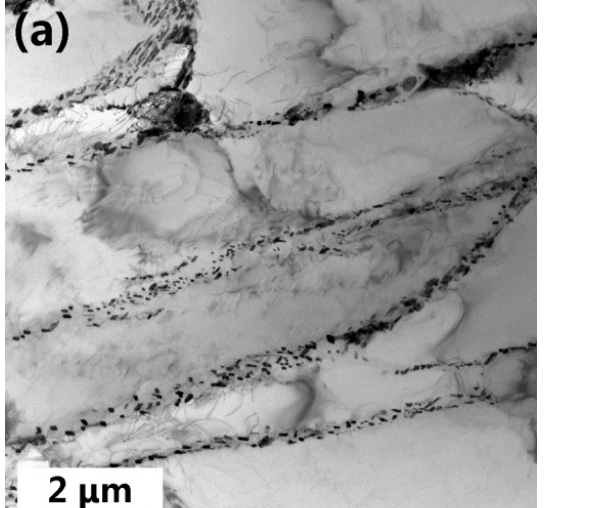
Figure 8. Cross-sectional macrostructure ( a ) and microstructure ( b ) of the post-deposition STA Ti60 alloy. The prior β grain boundaries in ( a ) were traced in white dots.